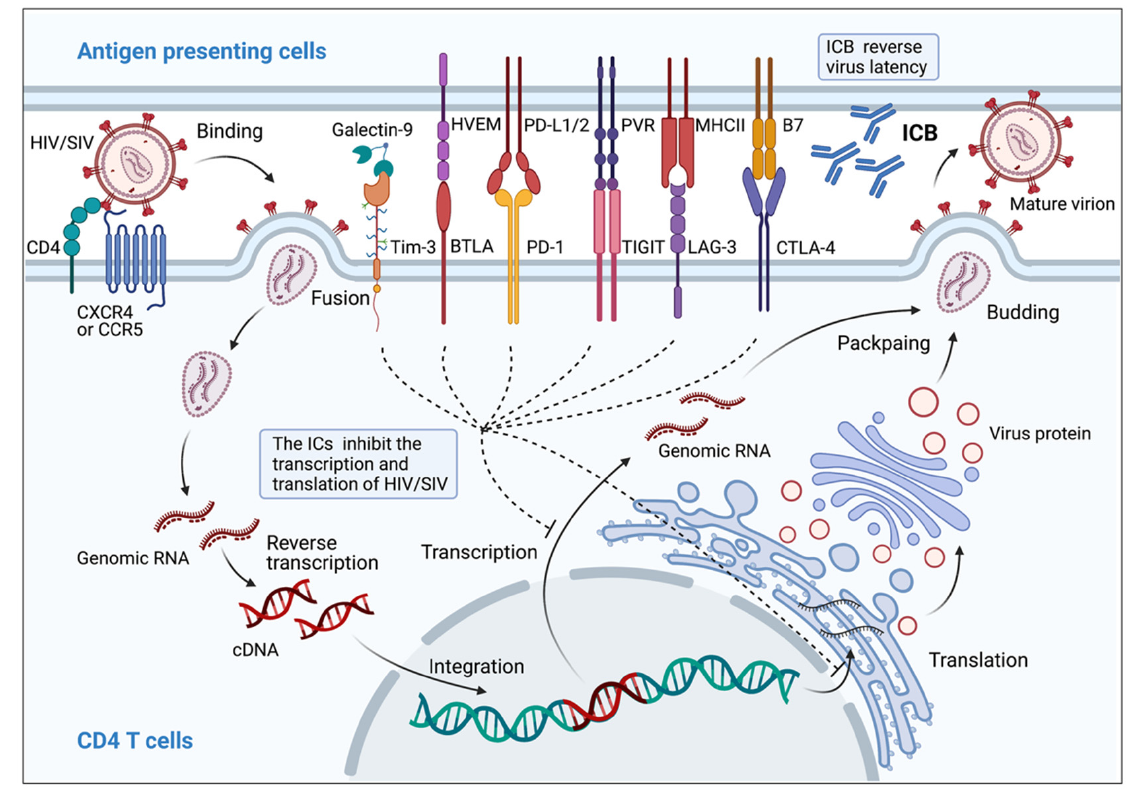
Figure 2. Immune checkpoint proteins contribute to HIV/SIV latency. PD-1, TIGIT, LAG-3, CTLA-4, Tim-3, and BTLA signaling pathways are involved in generating an HIV reservoir and its persis ‐ tence. The binding of these ICs and their ligands enforces silencing of integrated HIV DNA at the transcriptional and/or translational level. IC blockers can reactivate HIV from the cellular reservoir and produce new virions by blocking IC ‐ ligand interactions in CD4 + T cells.